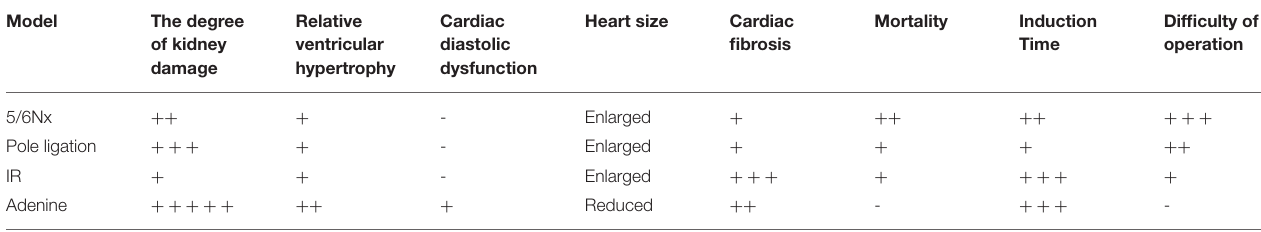
TABLE 1 | Comparison of characteristics between different models. Model The degree of kidney